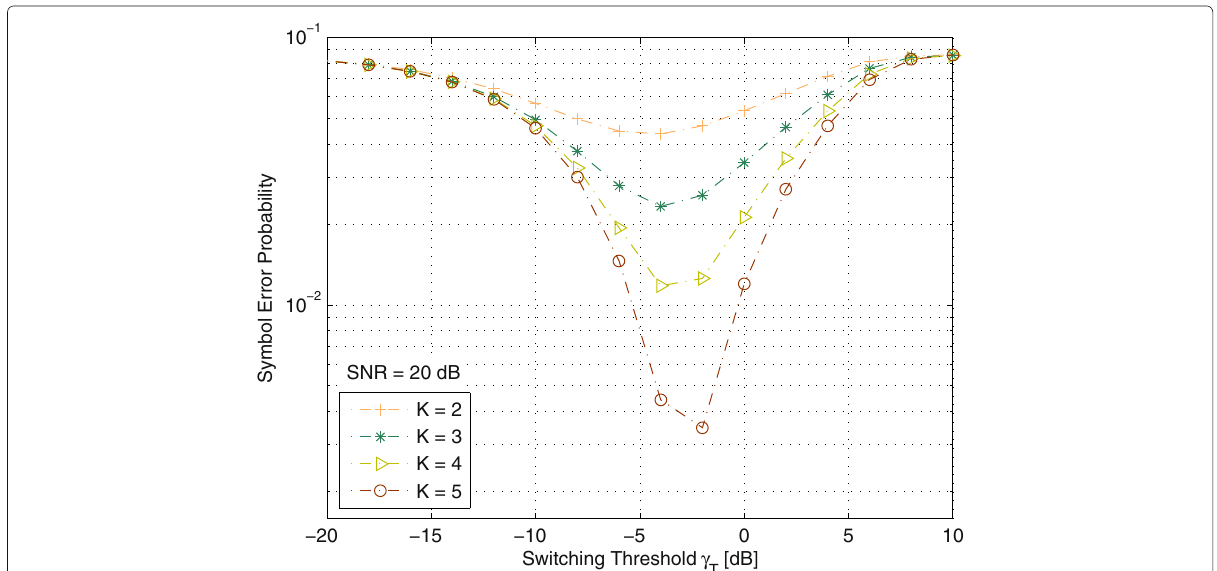
Fig. 7 Symbol error probability vs switching threshold of cognitive AF relay network with MUSwiD user selection scheme for different values of K and (cid:3) s,p = 20, and (cid:3) s,r = 0.1, (cid:3) r,p = 0.3, (cid:3) r, k = 0.2 for k = 1, ...